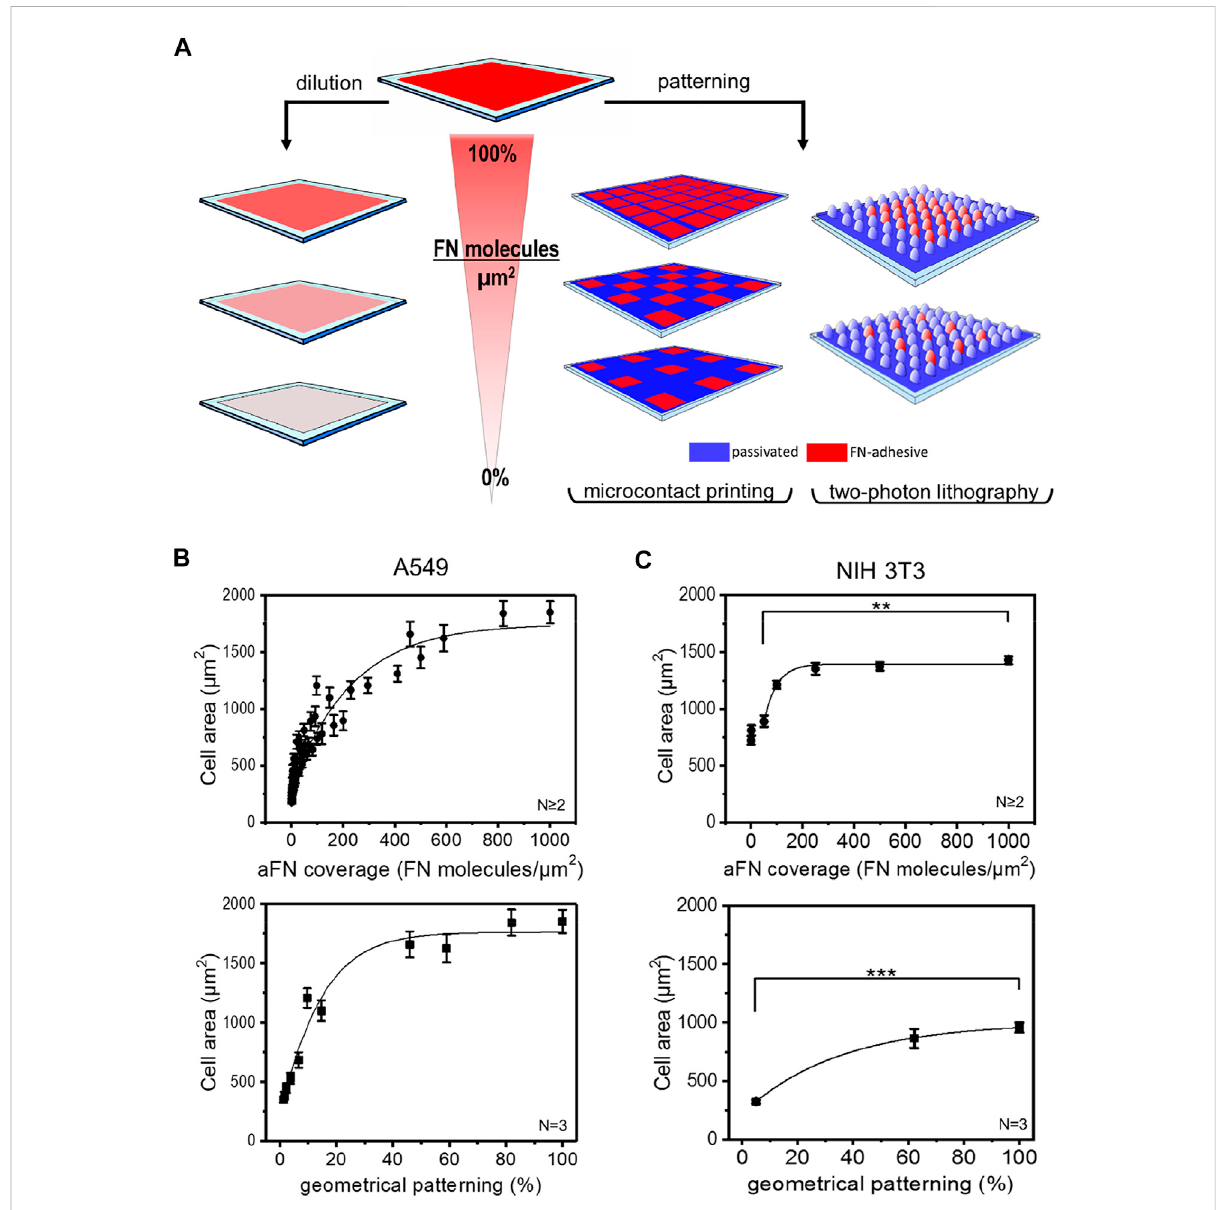
FIGURE 1 MicrofabricationtechniquesandcellareaspreadingondifferentlyFN-coatedsubstrates. (A) Overviewoftheapproachusedtostudytheeffects of ligand density on cell area spreading: fl at surfaces were functionalized with different fi bronectin (FN) dilutions, while micropatterns obtained via micro-contactprinting(µCP)andtwo-photonlithography(2PL)werecoveredwithundilutedFN.Thisstrategyallowedforchemicalandgeometrical variationofFNdensityonsubstrates,respectively. (B) A549cellareasmeasuredon fl atglasssurfaces(top,circles)andonµCPpatterns(bottom, squares). (C) NIH 3T3 cell areas measured on glass (top, circles) and on 2PL-patterned structures (bottom,